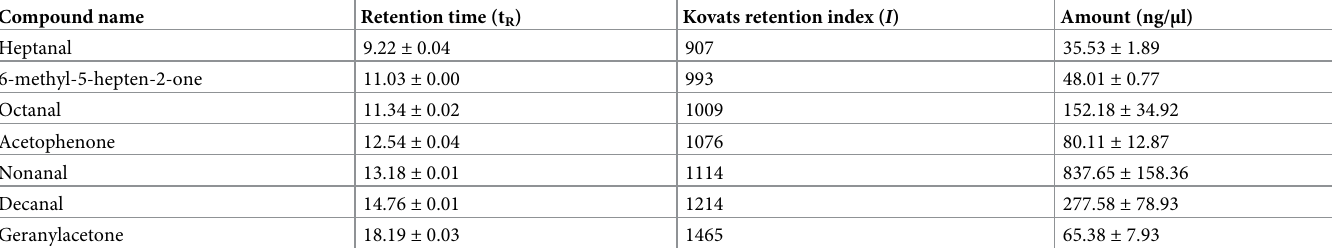
Table 1. Kovats retention index and amount ( ± SEM) of identified EAD-active compounds in zebra skin odor (n =